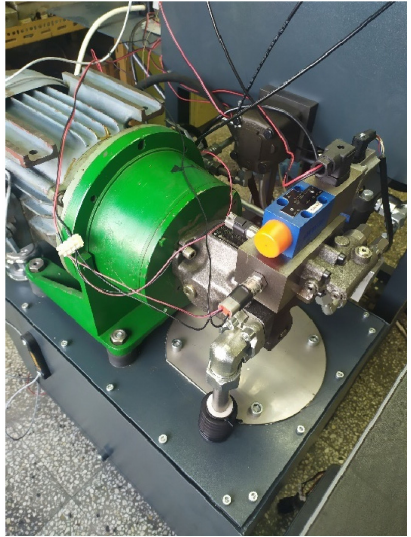
Figure 2. Photo of the implemented